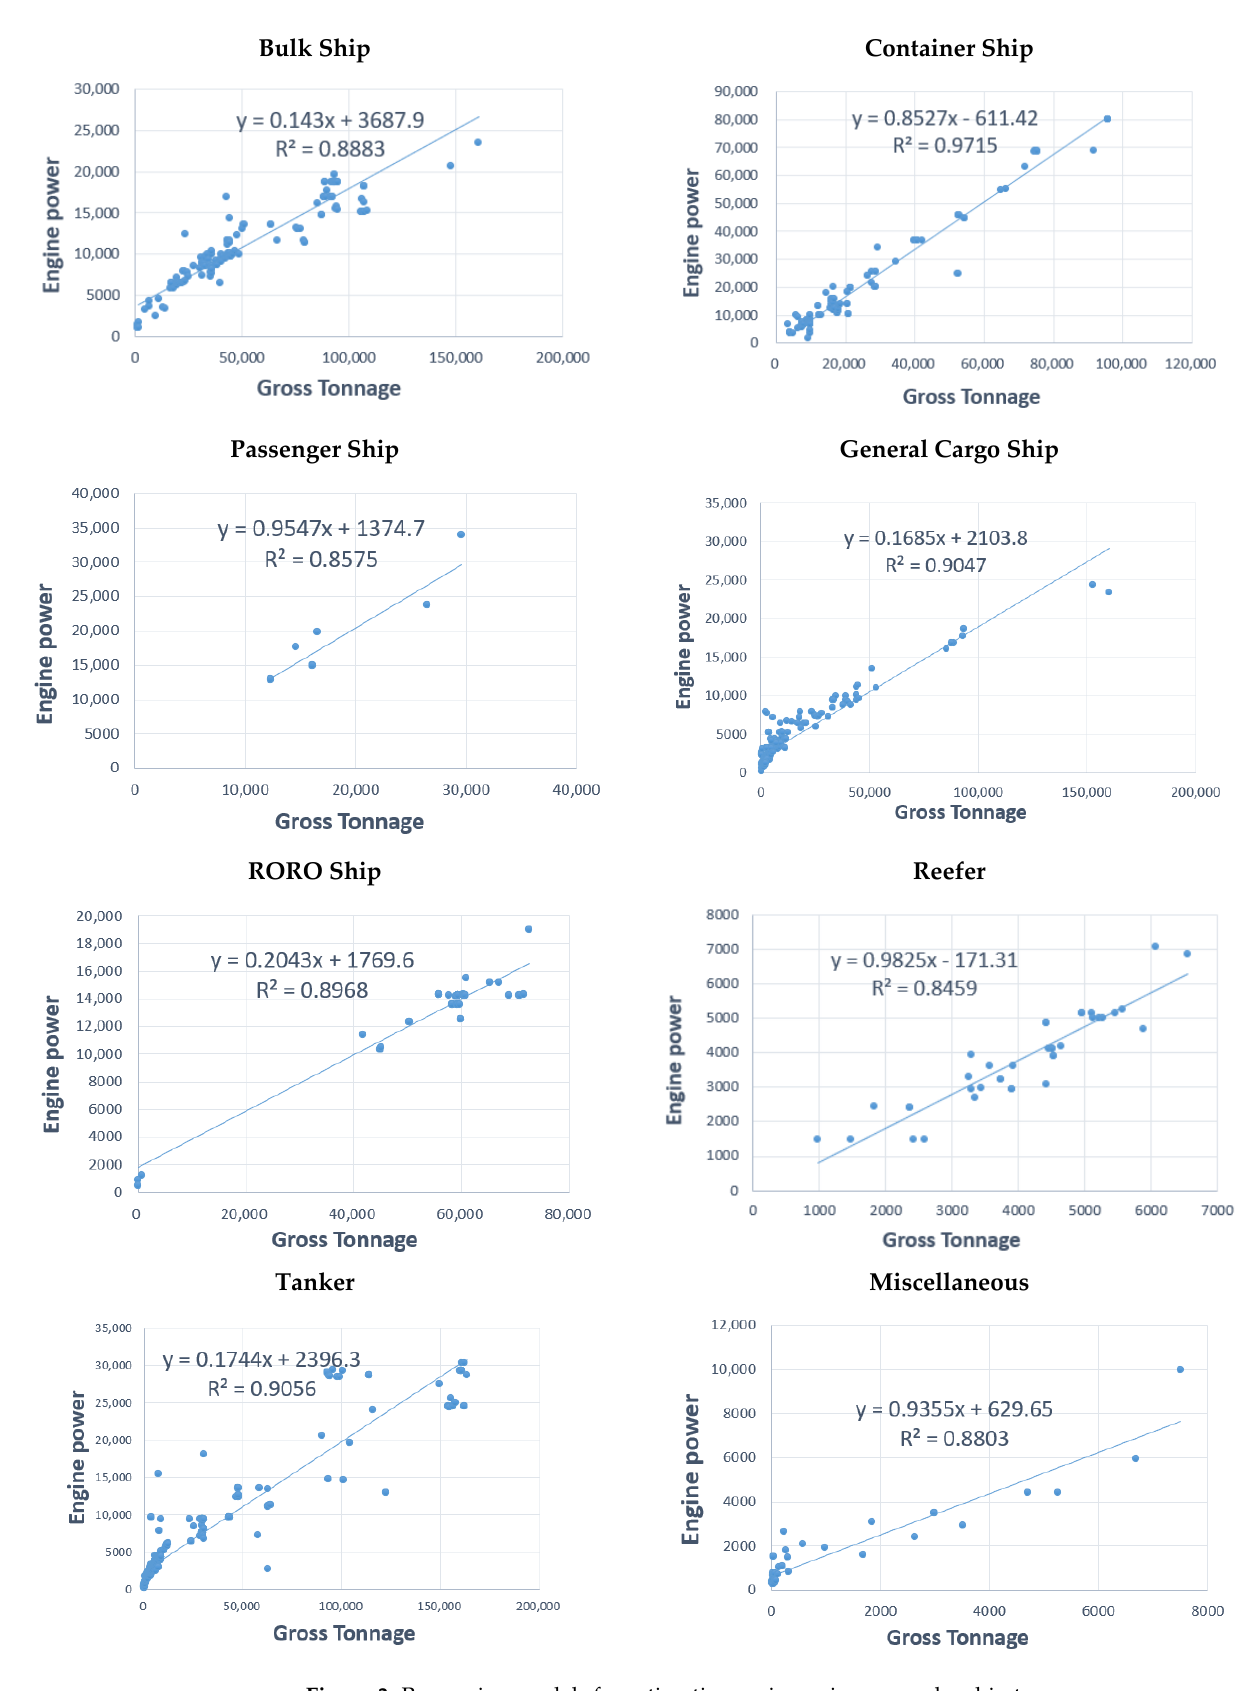
Figure 3. Regression models for estimating main engine power by ship type.